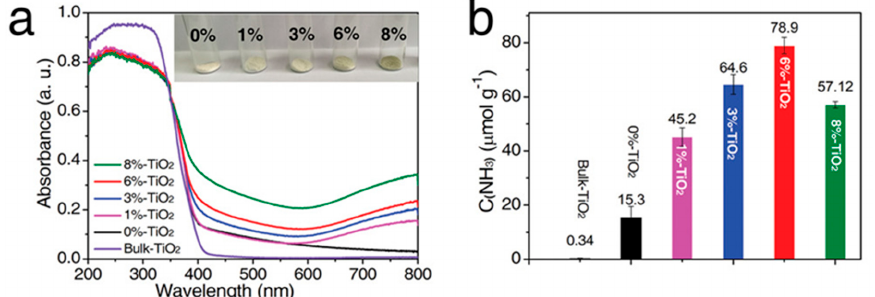
Figure 18. (a) UV ‐ DRS of X % ‐ TiO 2 nanosheets (X = 0, 1, 3, 6, 8) and Bulk ‐ TiO 2 (the inset shows a Figure 18. ( a ) UV-DRS of X%-TiO2 nanosheets (X = 0, 1, 3, 6, 8) and Bulk-TiO 2 (the inset shows a photograph of the X % ‐ TiO2 nanosheets). ( b ) Photocatalytic nitrogen fixation activity of TiO 2 with photograph of the X%-TiO 2 nanosheets). ( b ) Photocatalytic nitrogen fixation activity of TiO 2 with di ff erent doping concentrations under UV–Vis after 1 h. Reprinted with permission from [269].